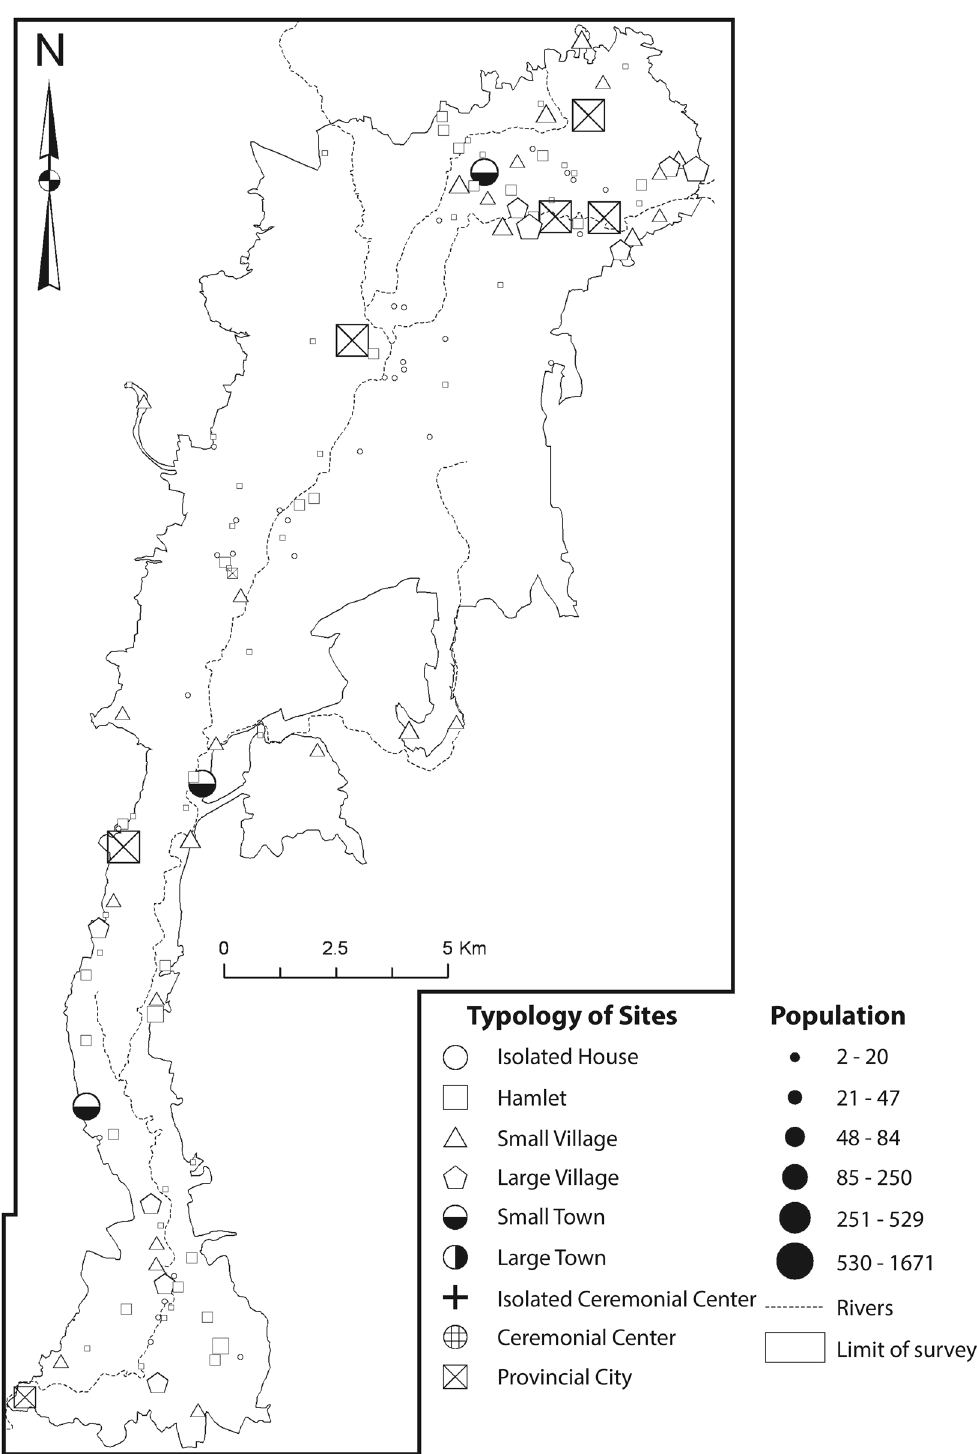
Figure 15: Settlement patterns of the Pochtla ( Middle Postclassic )